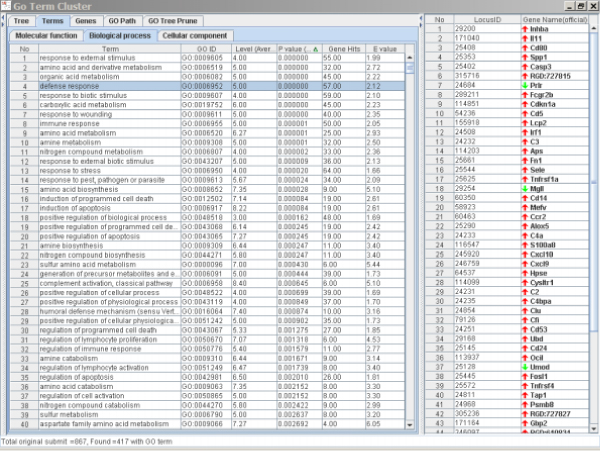
Significantly altered terms and the genes associated with defense response caused by AA treatment in rat kidney. The left panel is the Terms Window and the right panel is the Genes Window. The major genes in the list were up-regulated.